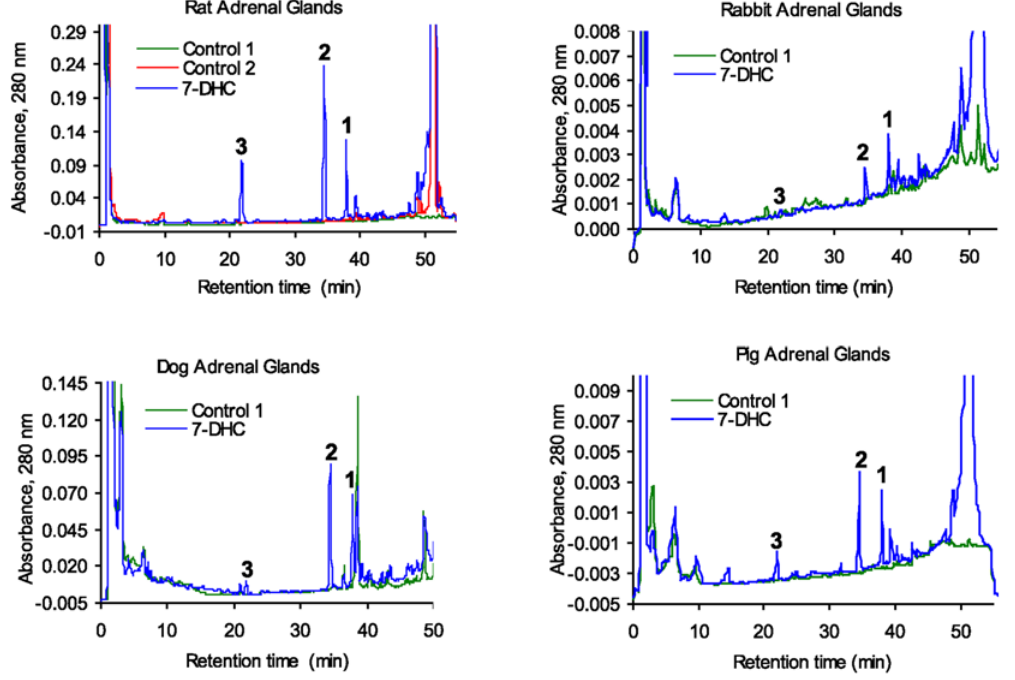
Figure 3. Metabolism of 7-DHC by adrenal glands of different mammalian species. Finely cut fragments of rat ( A ), rabbit ( B ), dog ( C ) and pig ( D ) adrenals were incubated in the presence (blue) or absence (green) of 7DHC (S). Boiled adrenal fragments served as an additional negative control for the rat ( red ). The three major products common to all animals studied are numbered 1 to 3 on the chromatograms. Product 3 had an identical retention time, mass, and UV spectra to 7DHP standard.